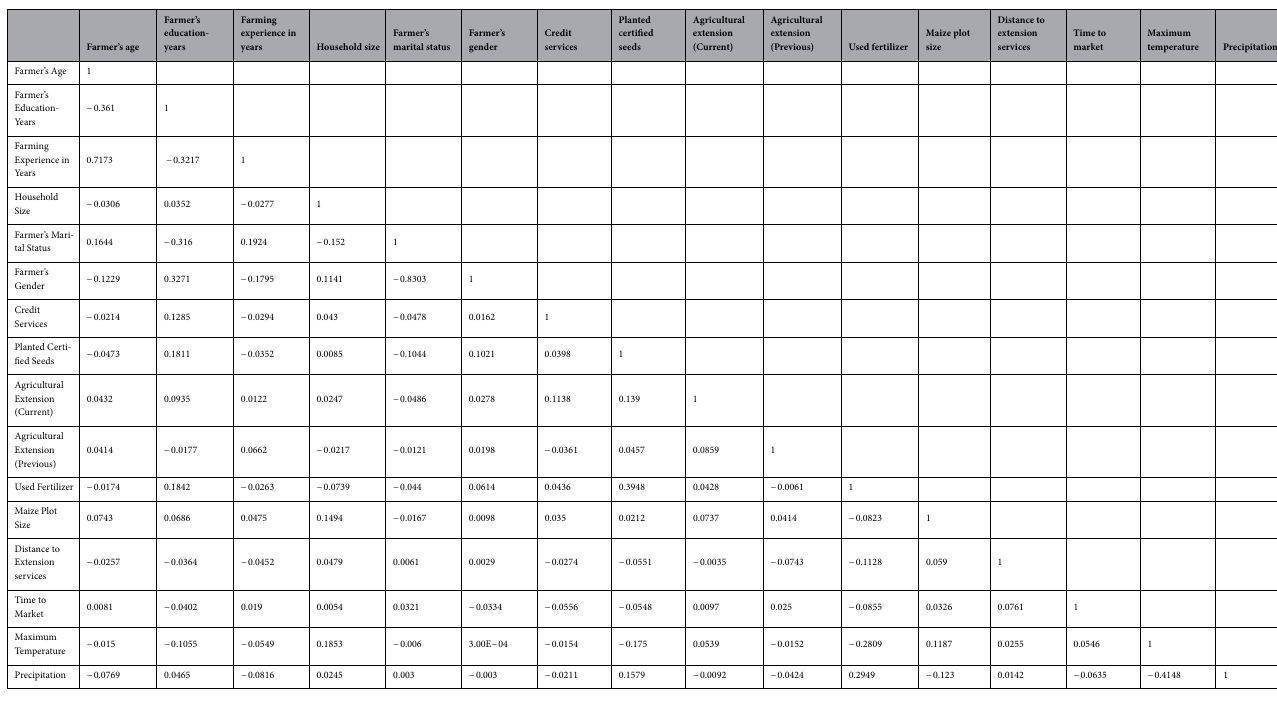
Table 1. Correlation matrix of all